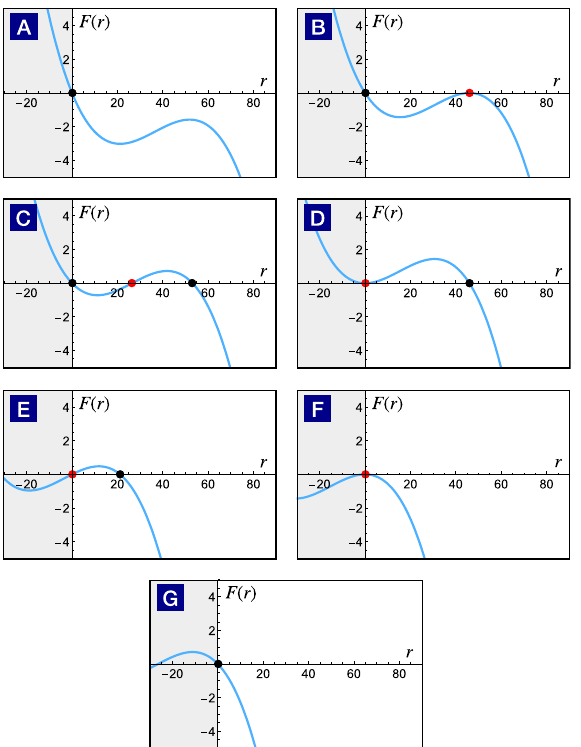
Figure 6. Dynamical phase transitions driven by the F ( r ) evolution. As the fitting function s ( I ) changes with the external current, the cubic function slides through different configurations from ( A ) to ( G ). The black and red points indicate the radius of the stable and unstable limit cycle respectively. Configurations from ( A ) to ( D ) show the birth of a pair of limit cycles and the unstable limit cycle swallows the stable fixed point at the origin subsequently. Compared with the previous classification scheme, it belongs to the subcritical Hopf transition. Configurations from ( E ) to ( G ) illustrate the process of a stable limit cycle shrinks to an unstable fixed point, leading to a stable fixed point subsequently. This dynamical transition belongs to the supercritical Hopf